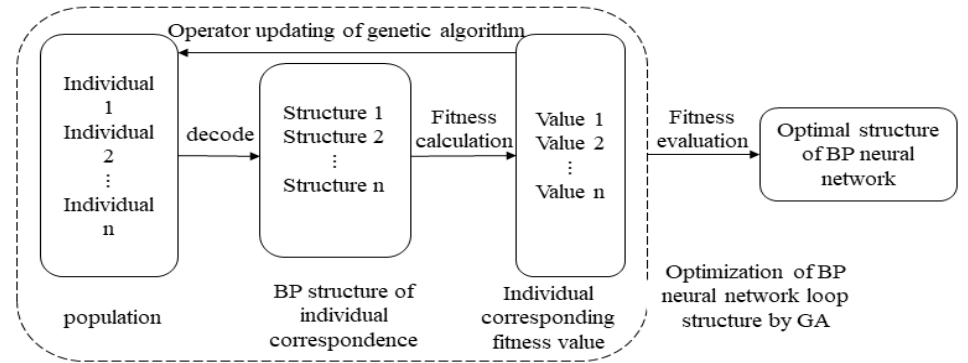
Figure 2. Optimization of BP neural network structure parameters by GA.